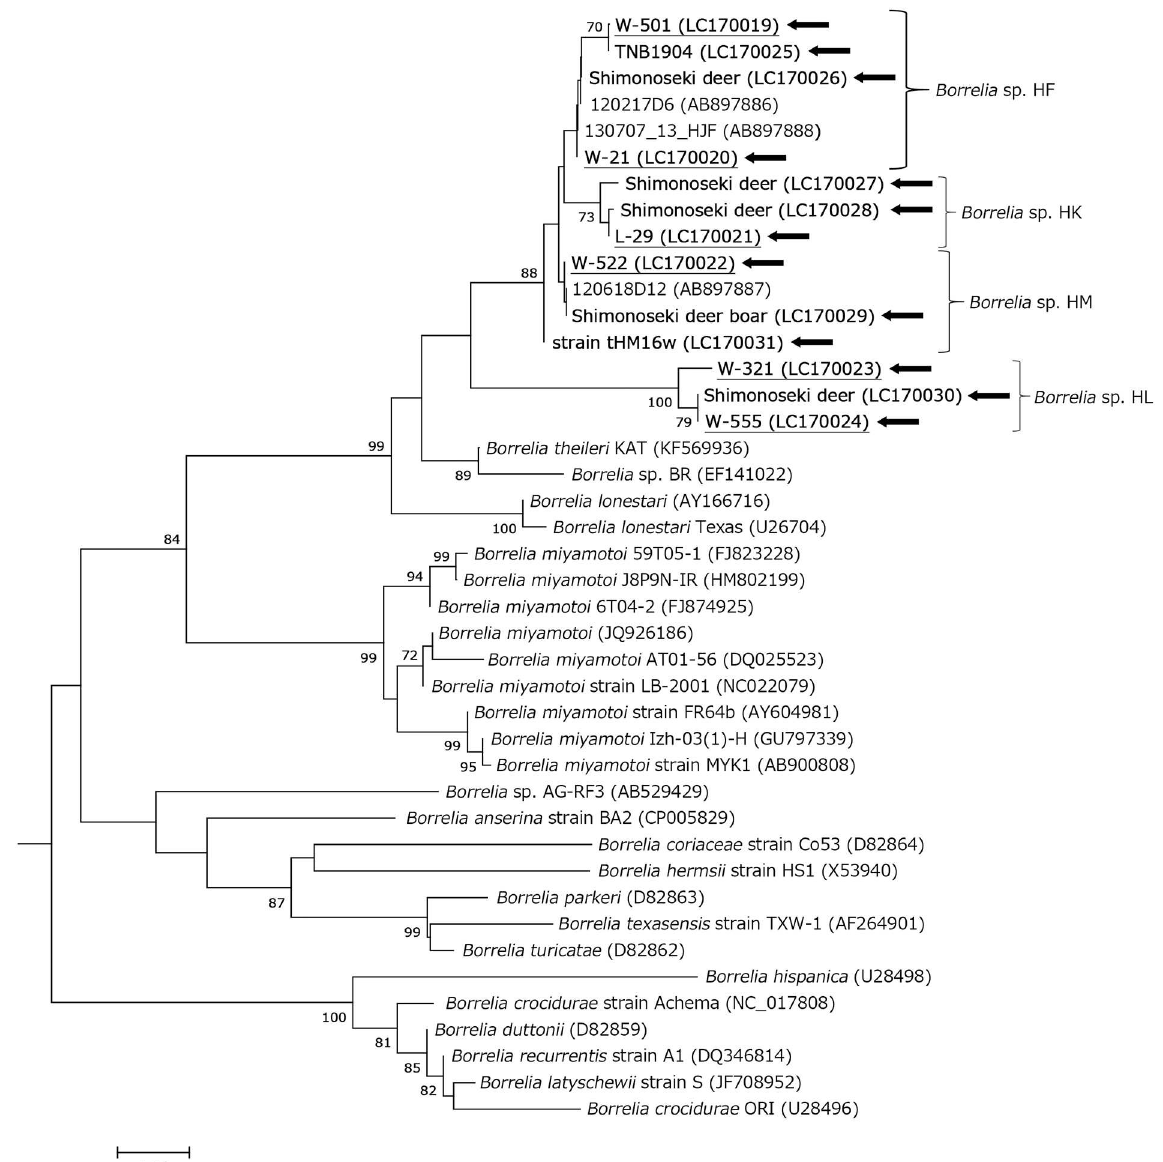
Fig 2. Phylogenetic analysis of flaB in Borrelia spp. The tree was constructed using the neighbor-joiningmethod based on the Kimura two-parameter model. The phylogeneticbranches were supportedby > 70% accordingto the bootstrap analysis. The bar indicatesthe percentage of sequencedivergence. B . afzelii VS461 (accession no. D63365), B . burgdorferi B31 (AB035617), and B . garinii 20047 (AB035602) were used as outgroups(data not indicated). Pointingarrows and bold type indicatethe results obtained in the present study. TNB1904is the raccoonsample from Wakayama Prefecture. Underlinedsamples were derived from ticks. Numbers in parenthesesrepresent GenBank accession numbers.